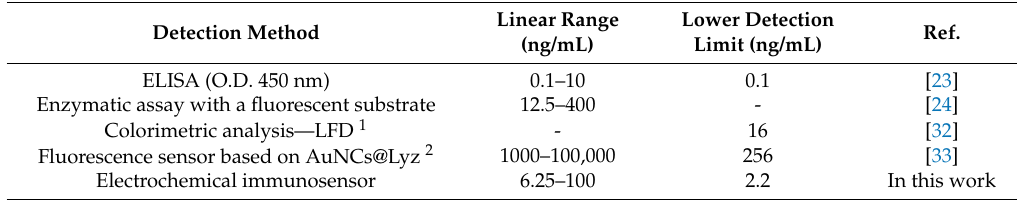
Figure 4. ( A ) Differential pulsed voltammetry (DPV) curves of the immunosensor after incubation with pepsin in the concentration range from 0 to 100 ng/mL; ( B ) calibration curve between the current change ( ∆ I) and log pepsin concentration from 6.25 to 100 ng/mL for the developed immunosensor; ( C ) changes in immunosensor current after incubation with 100 ng/mL pepsin and other interfering proteins (100 µ g/mL), such as lysozyme, amylase, and albumin; and ( D ) Comparison of sensitivity toward pepsin between the GNP/PPNCs/SPCE-based immunosensor and the SPGE-based immunosensor. Table 1. Sensing performance comparison of the developed immunosensor with other pepsin detection